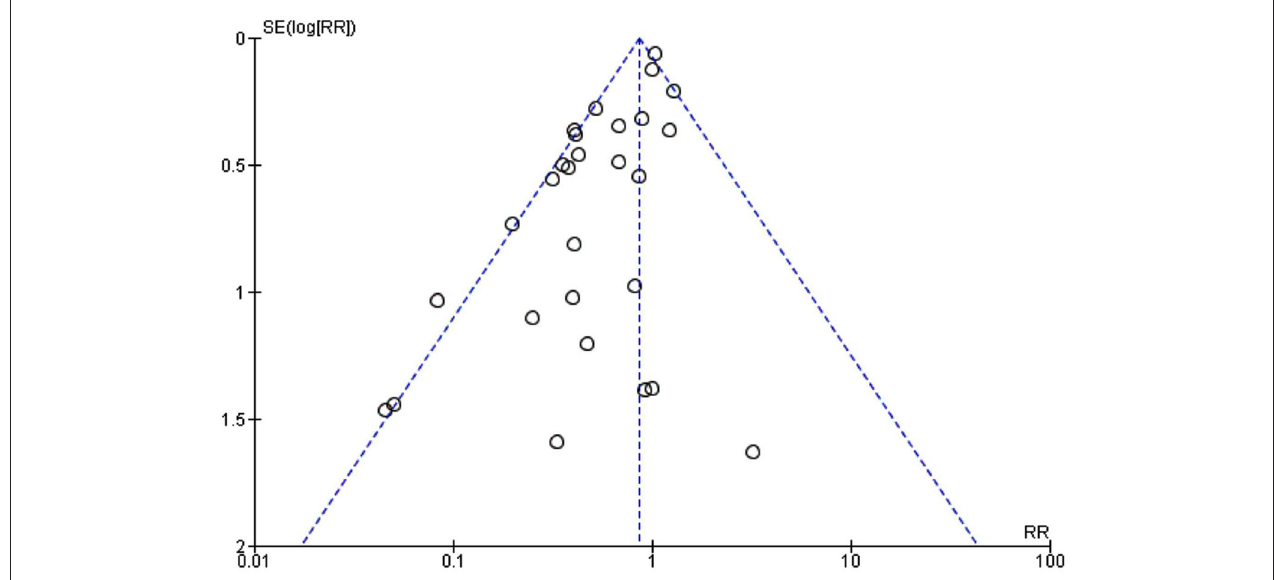
FIGURE 3 | A funnel plot to assess publication bias in meta-analysis with the surgical site infection (SSI)